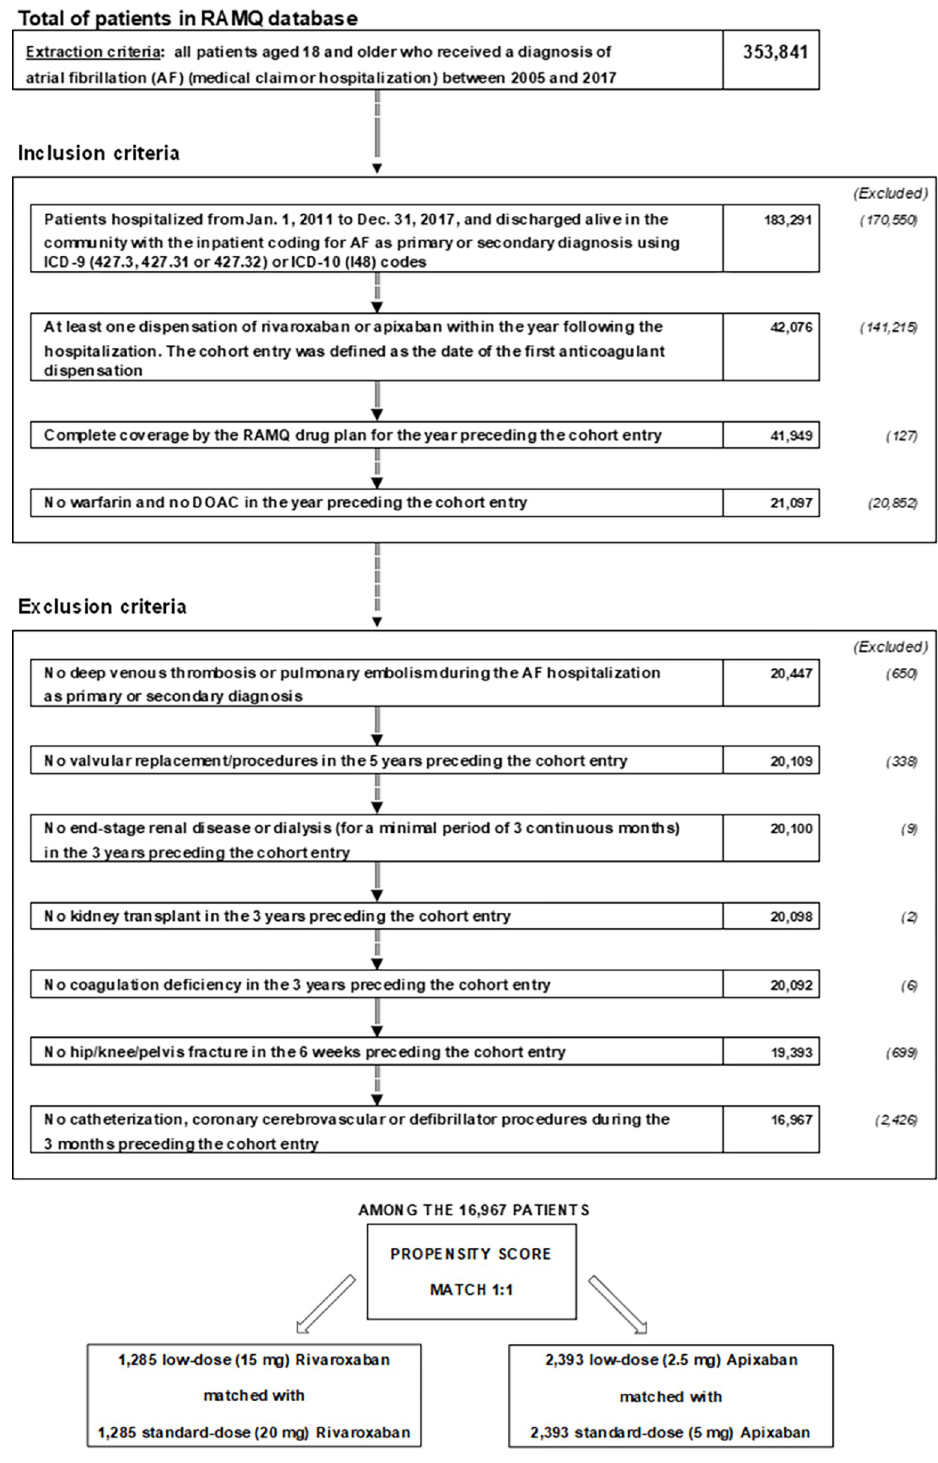
Fig 1. Flow chart of the study design and patient selection process. AF: atrial fibrillation; OAC: oral anticoagulant; RAMQ: Re´gie d’Assurance Maladie du Que´bec (Quebec administrative databases).